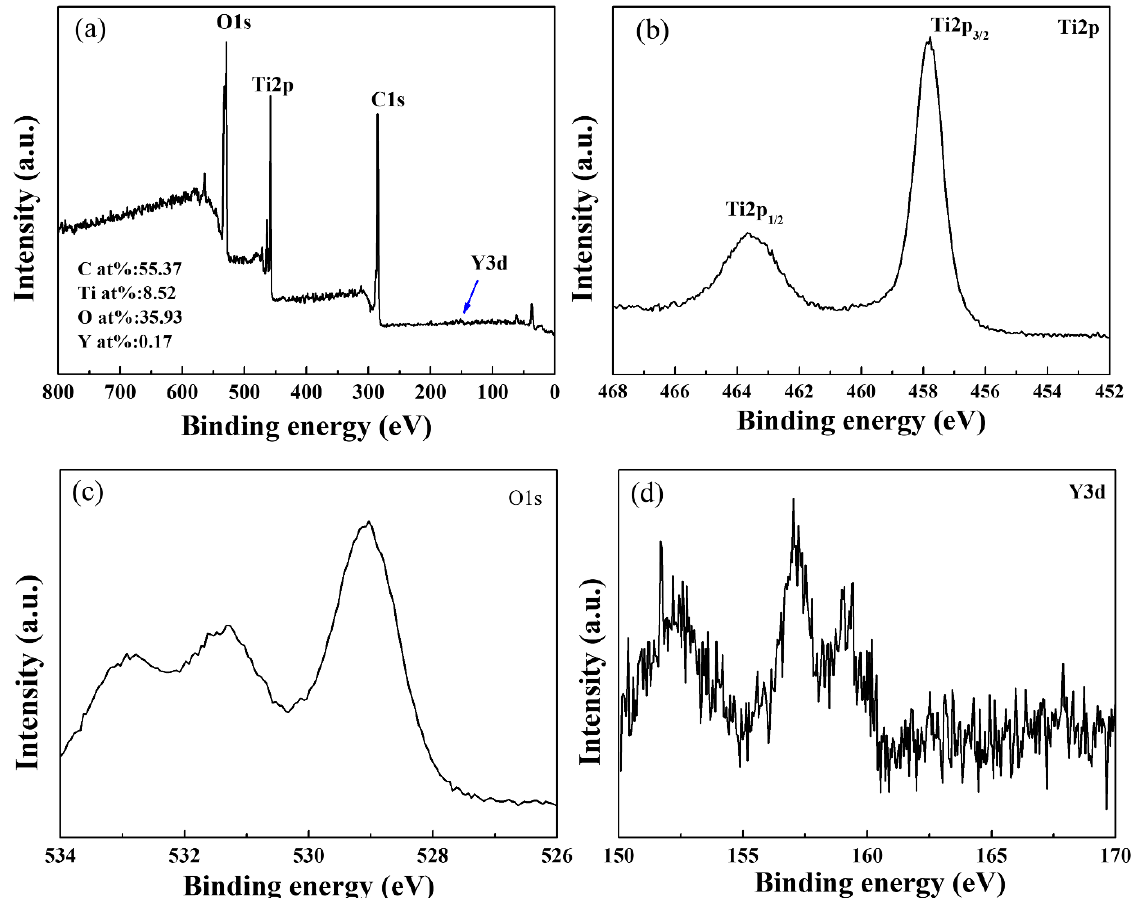
Figure 8. XPS survey of Y 2 O 3 /TiO 2 -loaded polyester fabric: ( a ) full peak of Y 2 O 3 /TiO 2 -loaded polyester fabric, ( b ) Ti2p peak, ( c ) O1s peak, ( d ) Y3d peak. polyester fabric, ( b ) Ti2p peak, ( c ) O1s peak, ( d ) Y3d